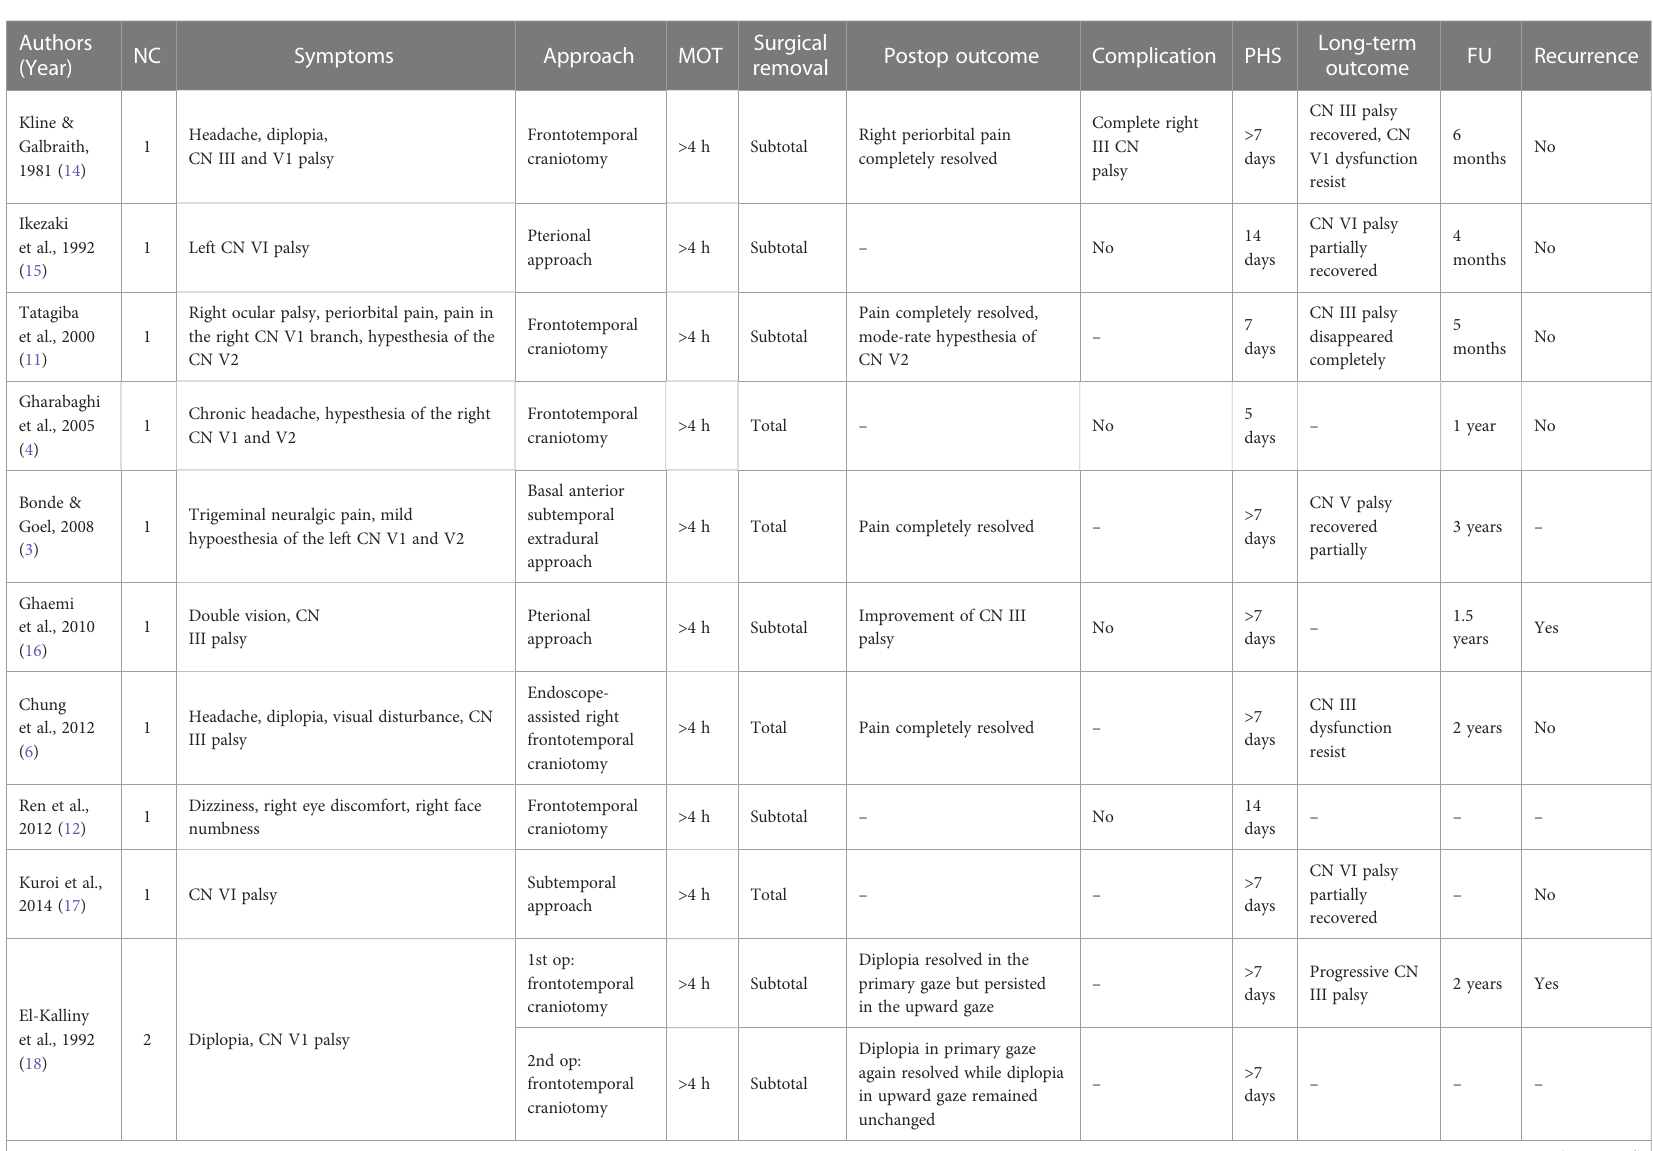
TABLE 1 Case summaries for 49 patients with CS epidermoid